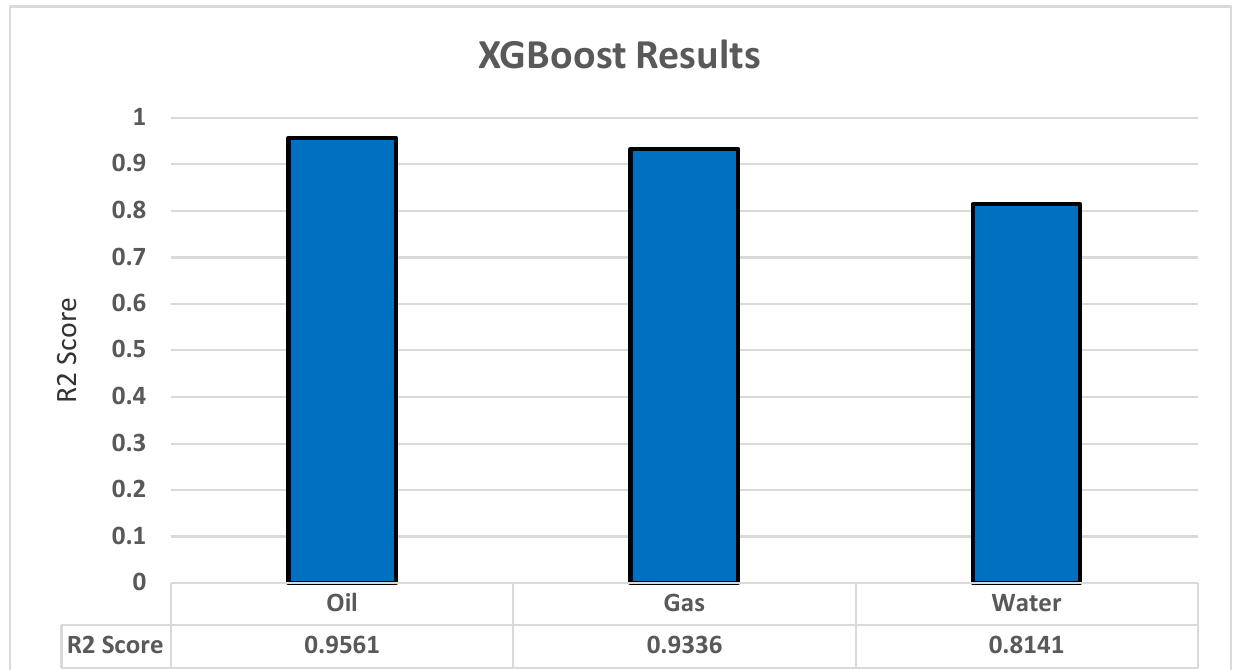
XGBoost: Comparison of R2 scores for oil, gas, and water Figure 9. XGBoost’s R2 score results. Figure 9. XGBoost’s R2 score